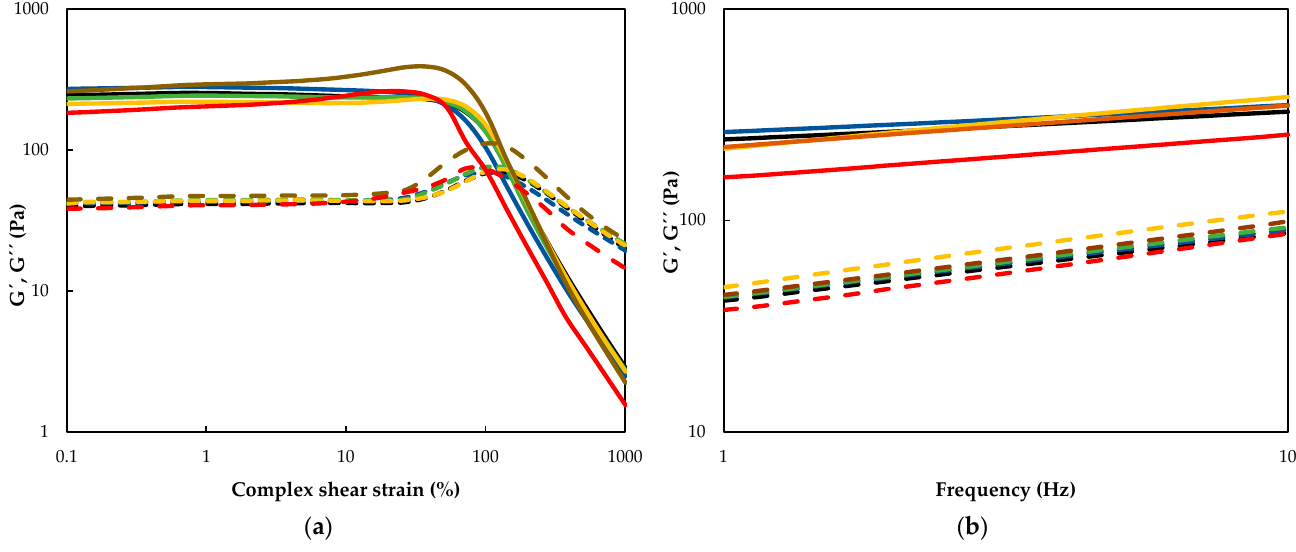
Figure 4. Strain sweeps ( a ) and frequency sweeps ( b ) of the analyzed flour gel samples. Black, blue, green, yellow, brown and red lines correspond to untreated, 1 min, 2 min, 4 min, 6 min, and 8 min treated samples, respectively. G ′ is represented by the solid line, while G ″ is represented by the dotted line.